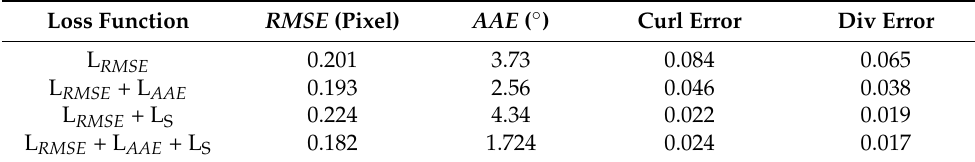
Table 4. Results of different loss functions on the large training data